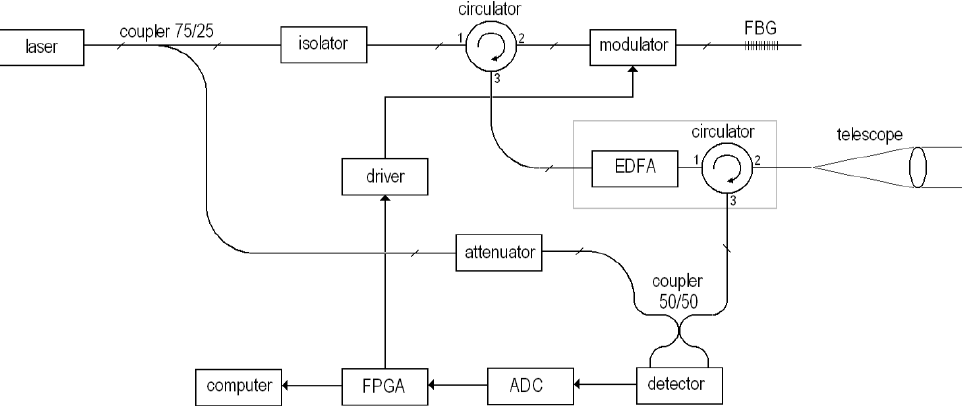
Fig. 1. Diagram of the all-fiber Doppler